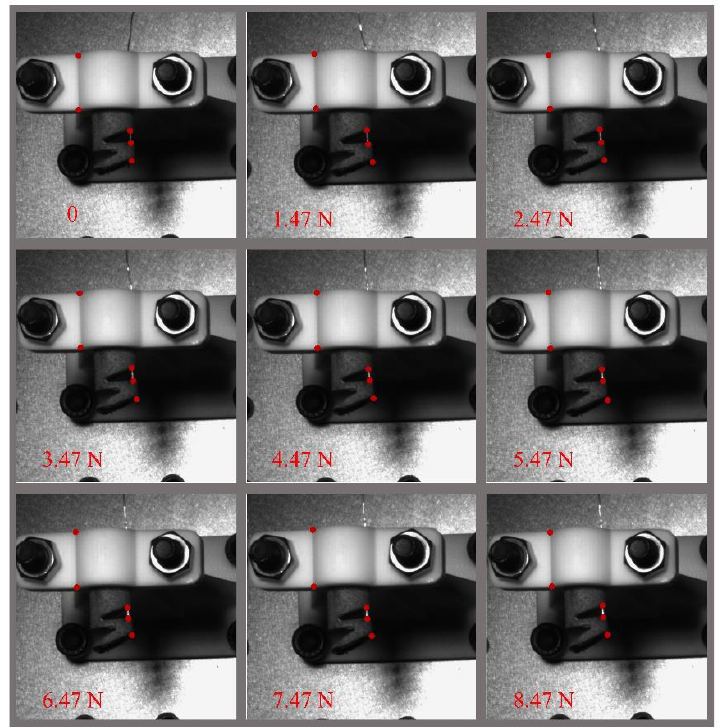
Figure 10. Elastic modulus calibration in a single-notched continuum robot.